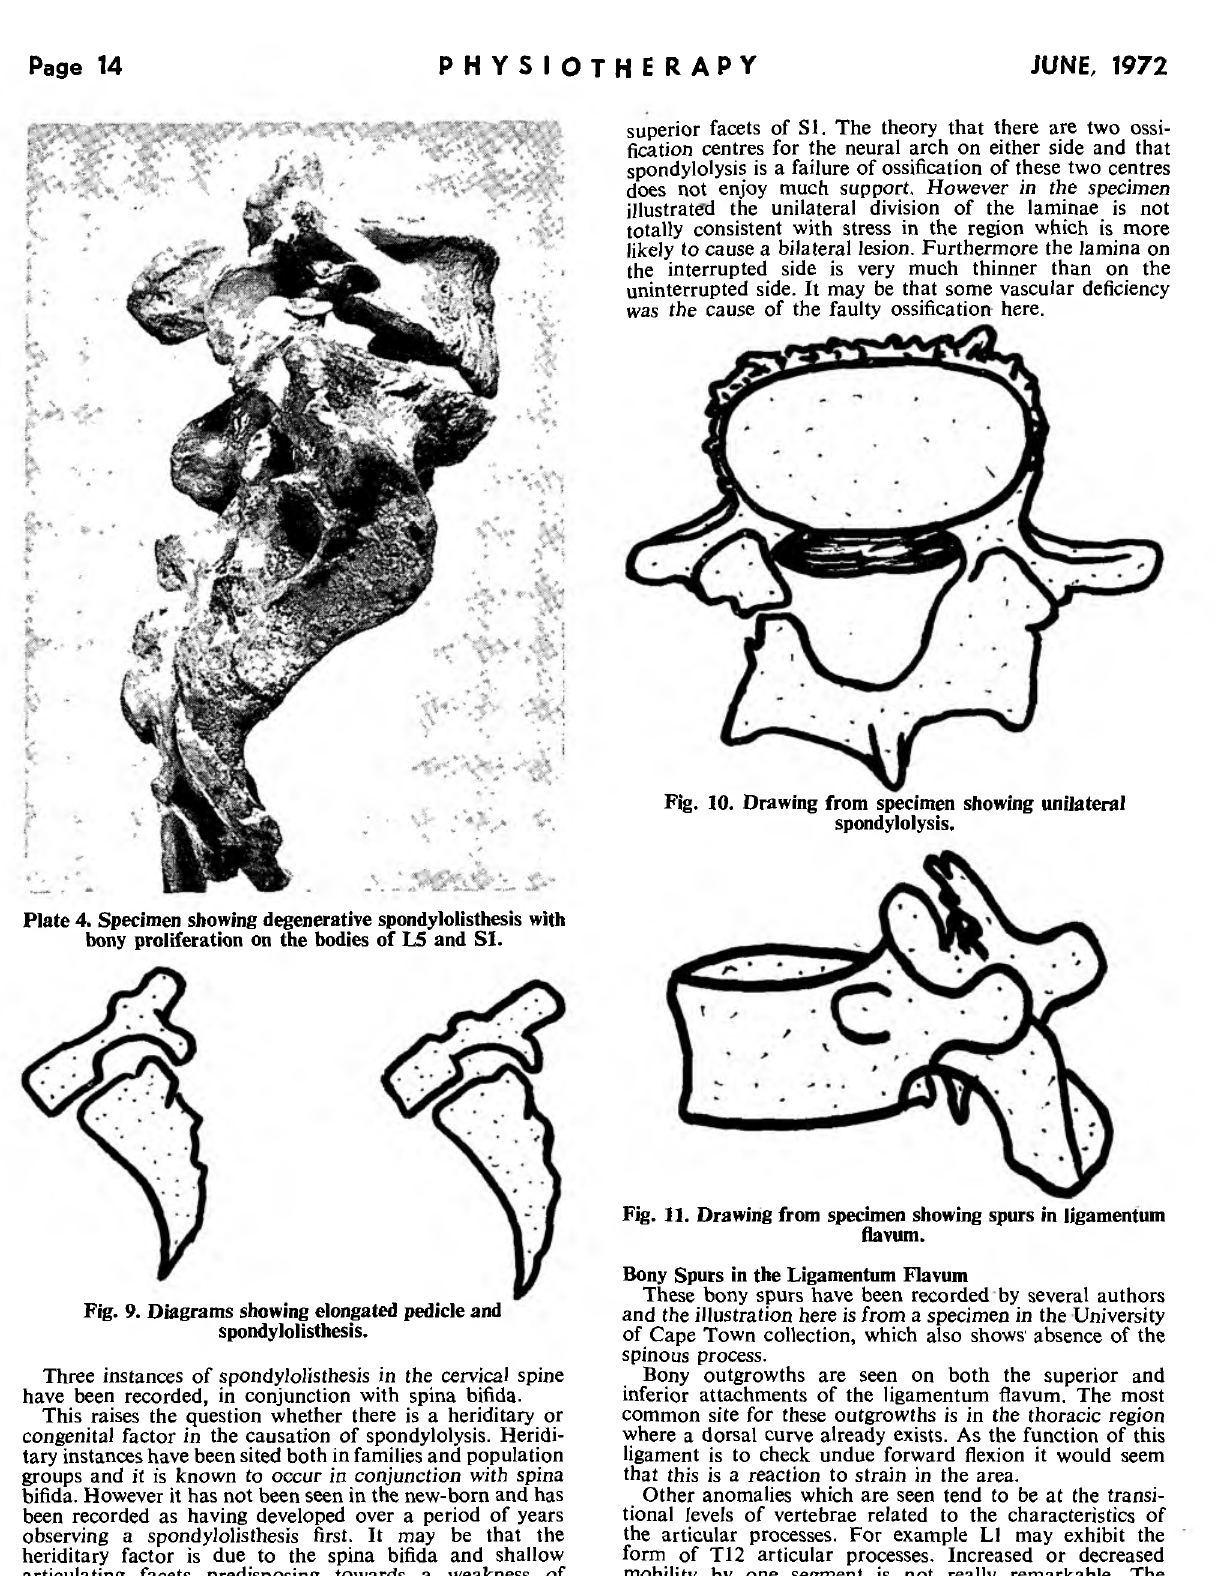
Fig. 11. Drawing from specimen showing spurs in ligamentum